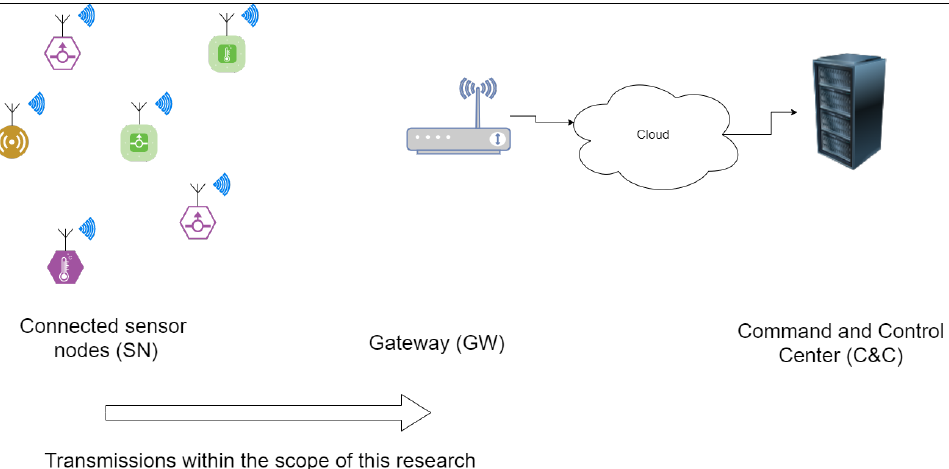
Figure 1. System model